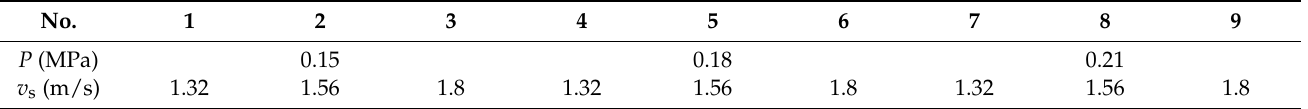
Table 4. Process parameters of no-load